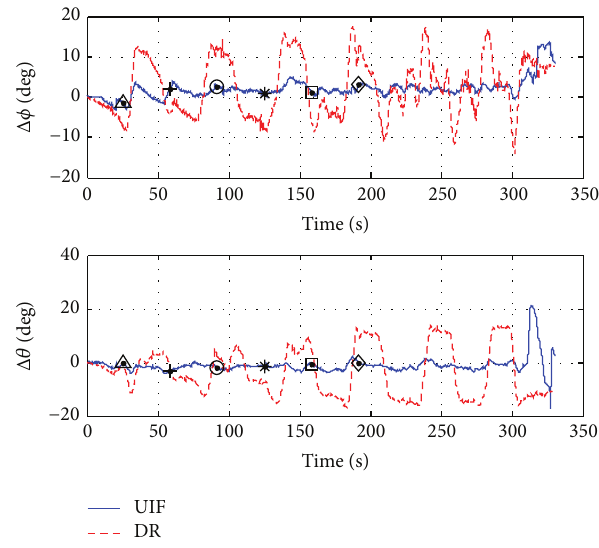
Figure 7: Estimated total speed for Flight #1.